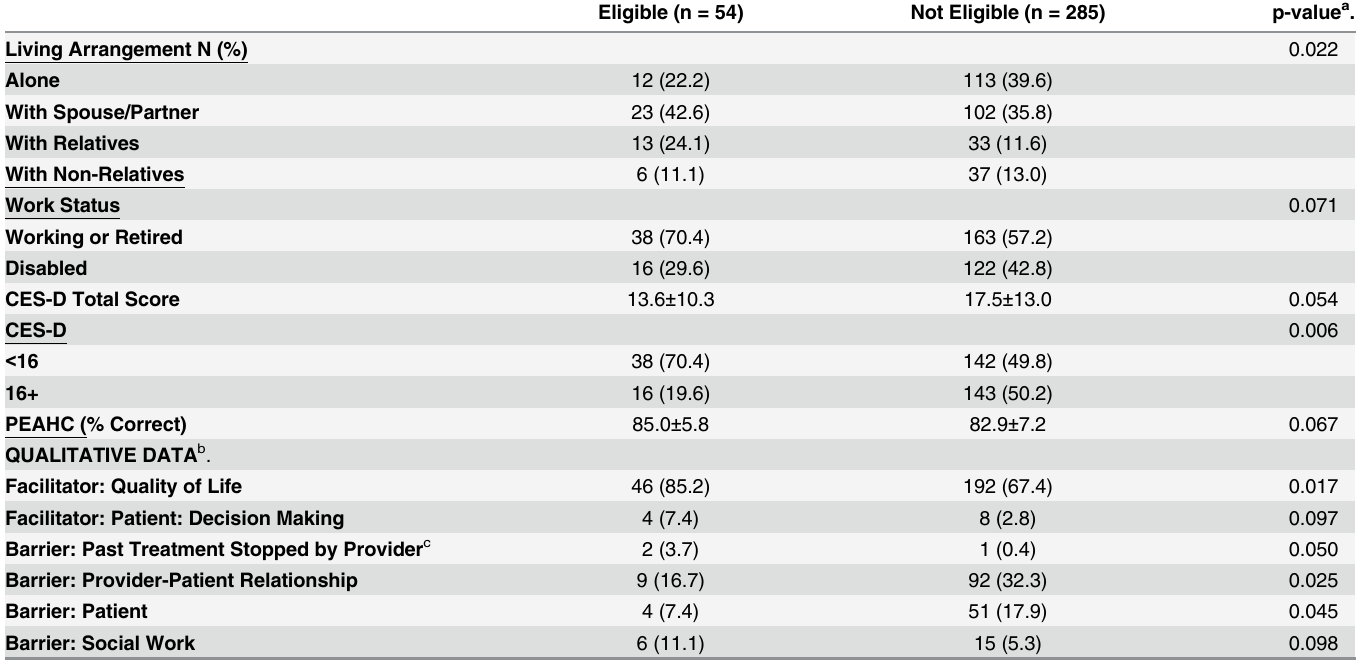
Table 2. Variables Meeting Selection Criteria from the Univariate Analyses of Treatment Eligibility.